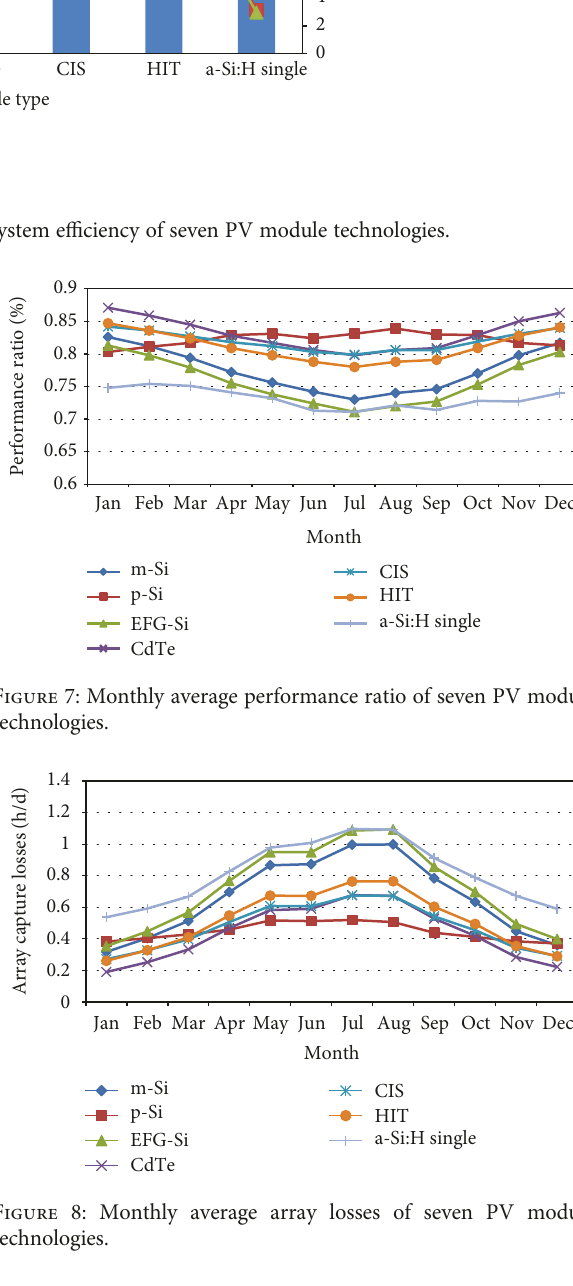
Figure 6: Monthly average fi nal yield of seven PV module technologies compared with the reference yield.